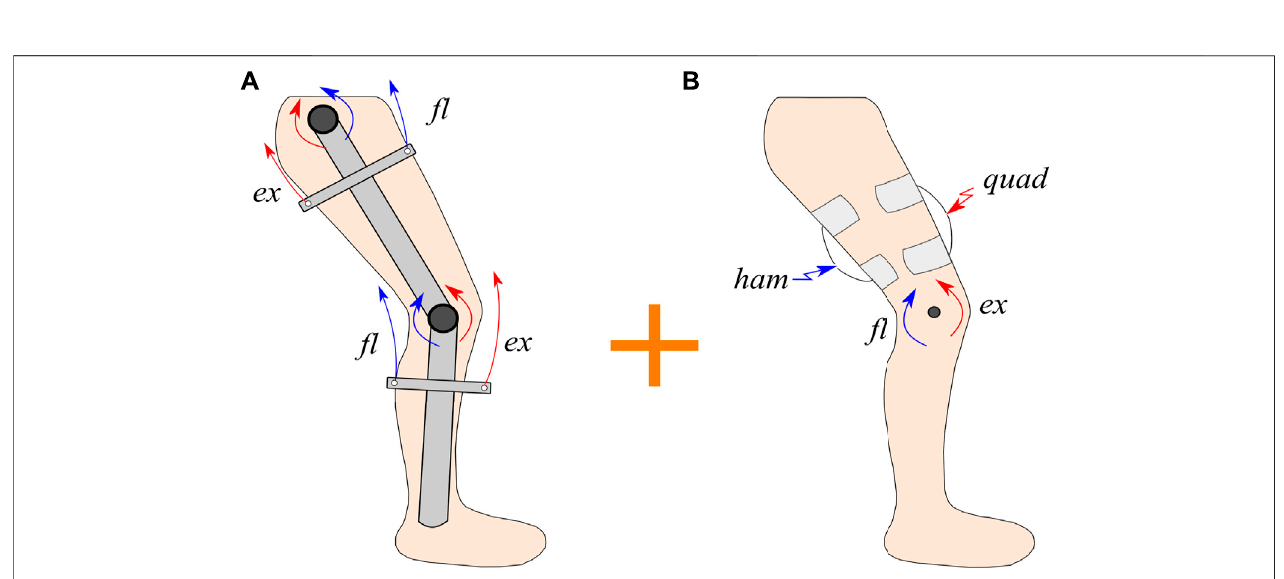
FIGURE2| Schematicofthehybridexoskeleton actuationfor walking. (A) The actuation ofthecable-drivenexoskeleton isillustrated, whereacoupleof fl exorand extensor cables on each joint are tensioned to provide torque about the joints. (B) The FES applied to the quadriceps (quad) and hamstrings (ham) muscle groups to generate torque about the knee joint is